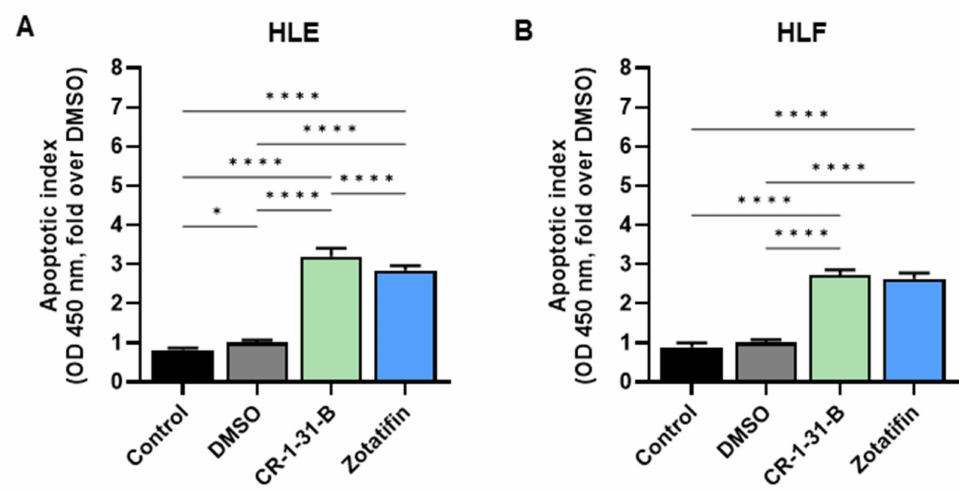
Figure 8. Effects of the eIF4A inhibitors, CR-1-31-B and Zotatifin, on the apoptosis of hepatocellular carcinoma cell line monolayer cultures. Cell death assay was conducted on ( A ) HLE and ( B ) HLF cells treated for 48 h with 10 nM CR-1-31-B and 20 nM Zotatifin. Untreated cells and cells treated with DMSO served as controls. The fold-changes over DMSO of optical densities (OD) at 405 nm are presented. All results are expressed as mean ± SD of three independent experiments in triplicate. For statistical analysis, Tukey’s multiple comparisons test was performed (* p < 0.05; **** p <